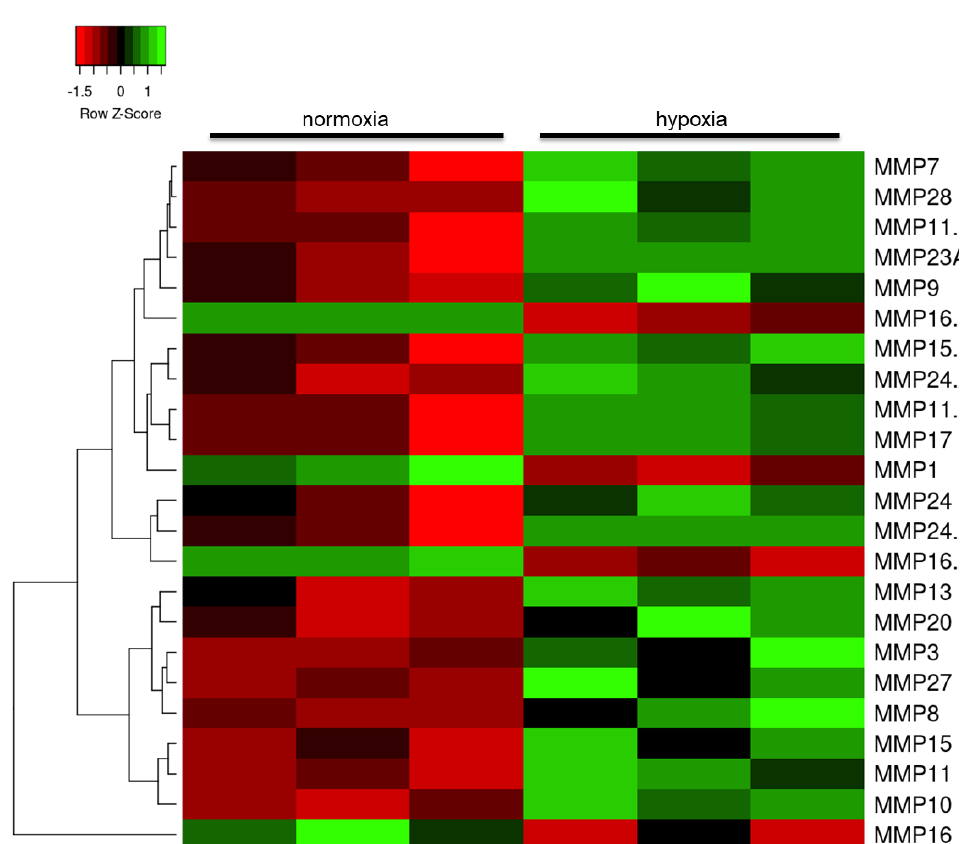
Figure 5. Heat map of matrix metalloproteinase (MMP) gene expression changes in human astrocytes in response to hypoxia. Red: downregulated transcripts; green: upregulated transcripts.